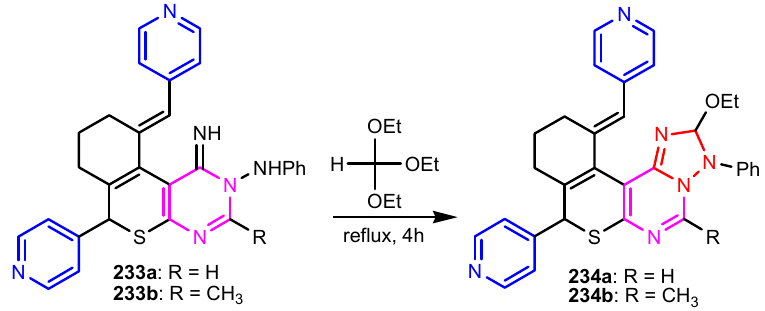
234a : R = H 234b : R = CH 3